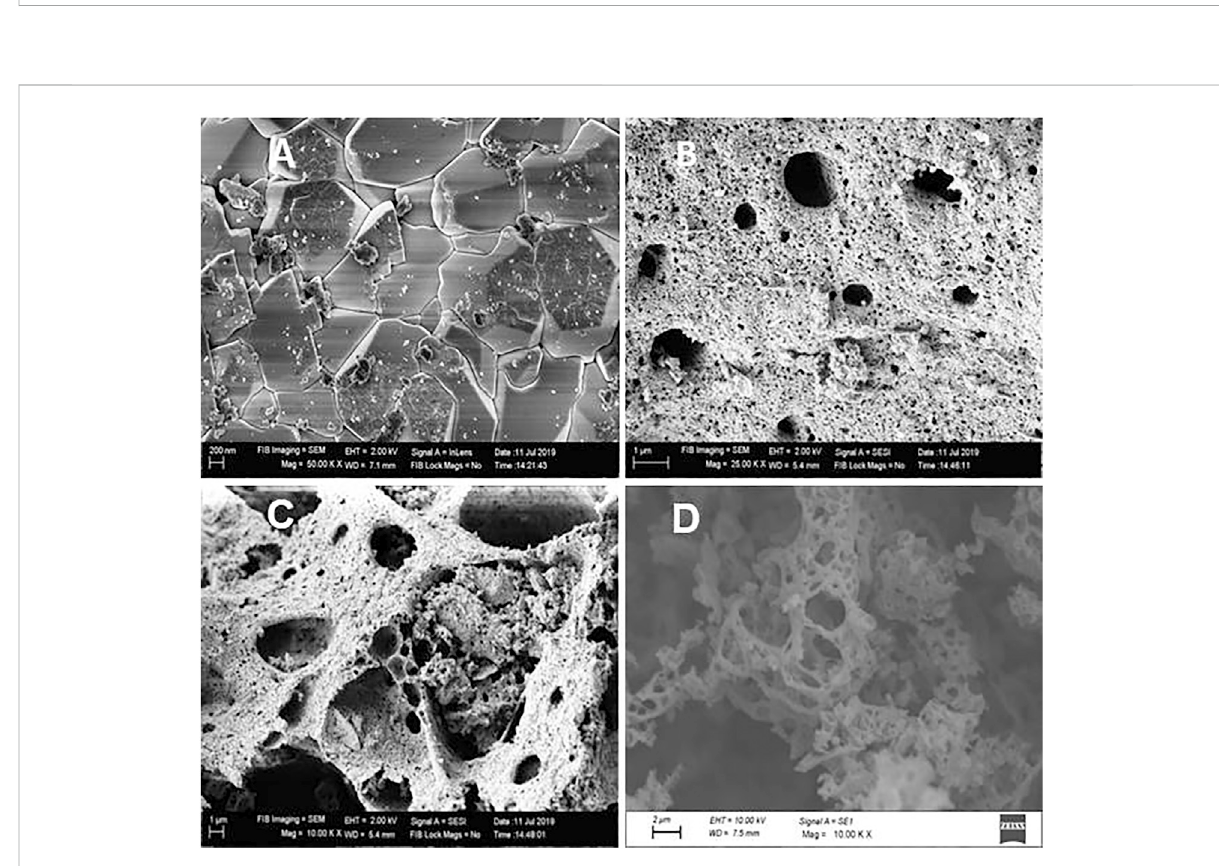
FIGURE 5 Morphological analysis: the SEM images (A) ZnO NPs, (B) PTP1, (C) PB2, and (D) PB1 NCs.